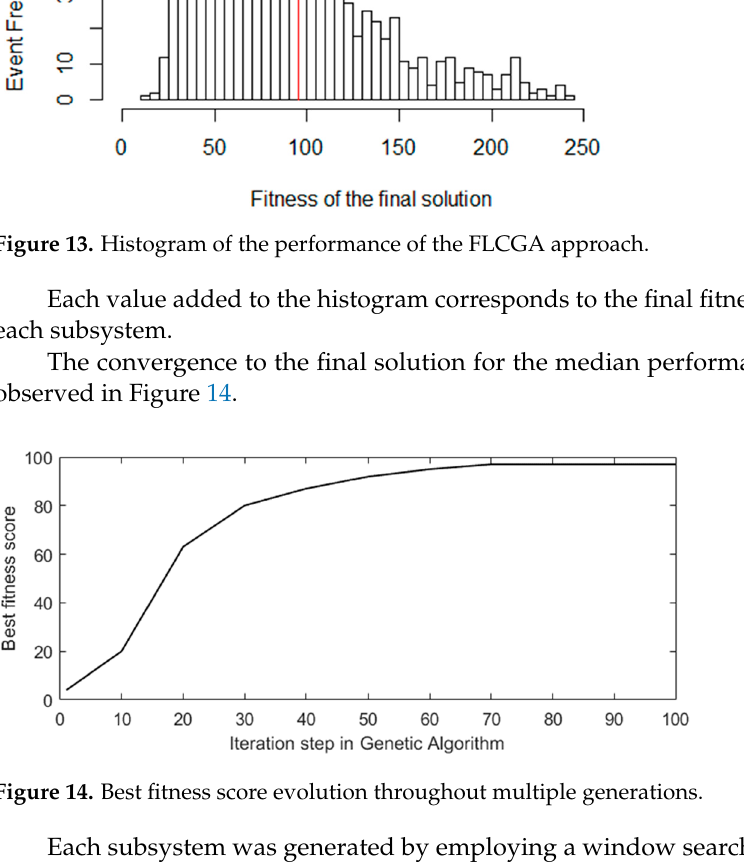
Figure 15. Example of window search performed on bike stations of Citi Bike, New York. 5.2. Comparative Experimentation and Analysis of FLC The experiments were repeated for di ff erent versions of the membership functions of the FLC, considered FLC instances. The repetition is aimed at discovering the optimal FLC instance, i.e., the one with the highest median fi tness score.